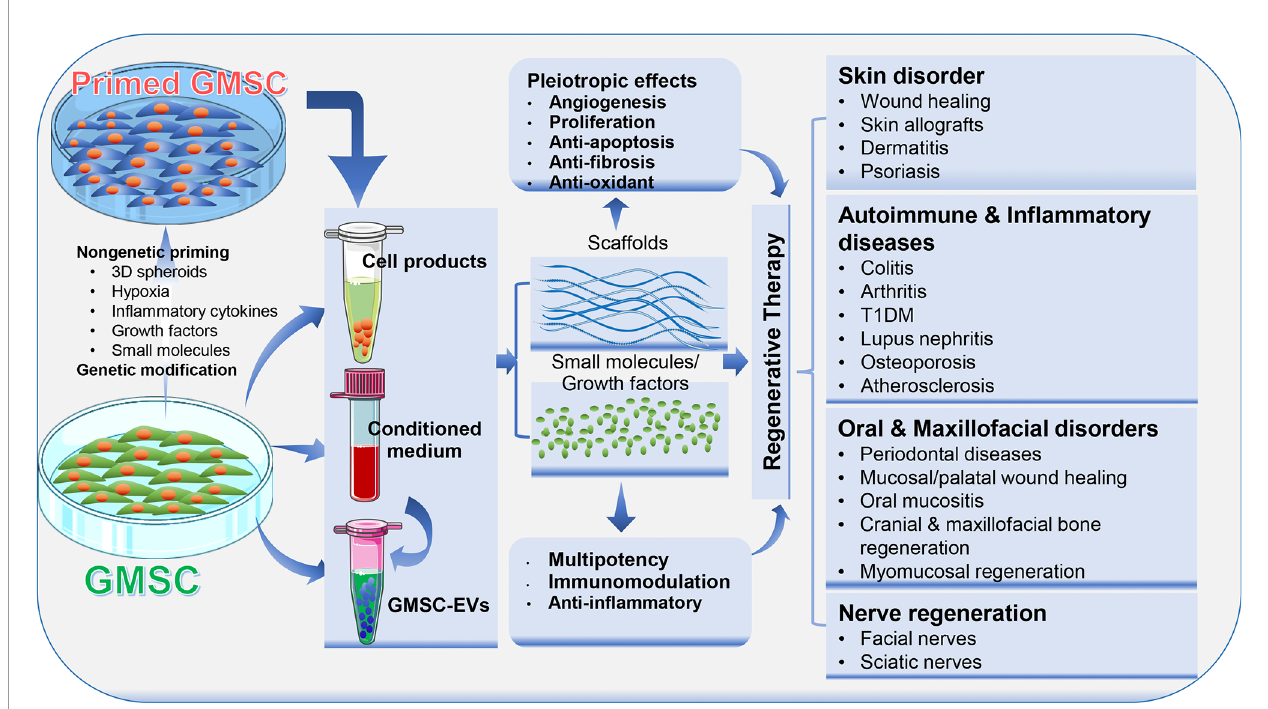
FIGURE 3 | Application of GMSCs and their cell-free products in regenerative therapy. Naïve or primed GMSCs, their derivative conditioned medium or extracellular vesicles (EVs) can be administered alone or in combination with certain scaffold, growth factor or small molecules. Due to the immunomodulatory/anti-in fl ammatory and pleiotropic effects, GMSCs and their derivative cell-free products exert potent regenerative and therapeutic potentials in a variety of preclinical models of human disorders. Portions of this fi gure were made using templates from SMART SERVIER MEDICAL ART